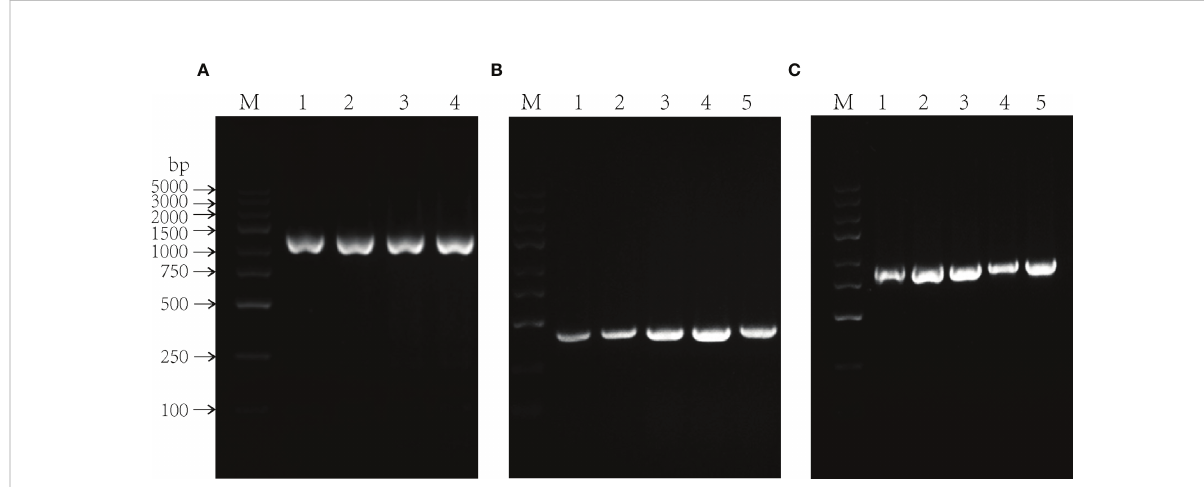
FIGURE 4 Molecular analysis of Agrobacterium tumefaciens containing recombinant expression vector. (A-C) PCR analysis of Agrobacterium tumefaciens using PlGPAT (A) , PlDHN2 (B) and PlHD-Zip (C) gene-speci fi c primers, respectively. PCR products in 1347, 399 and 972 bp were observed in each Agrobacterium tumefaciens using PlGPAT , PlDHN2 and PlHD-Zip gene-speci fi c primers, respectively. M, DL2000 marker; 1-5, different Agrobacterium tumefaciens